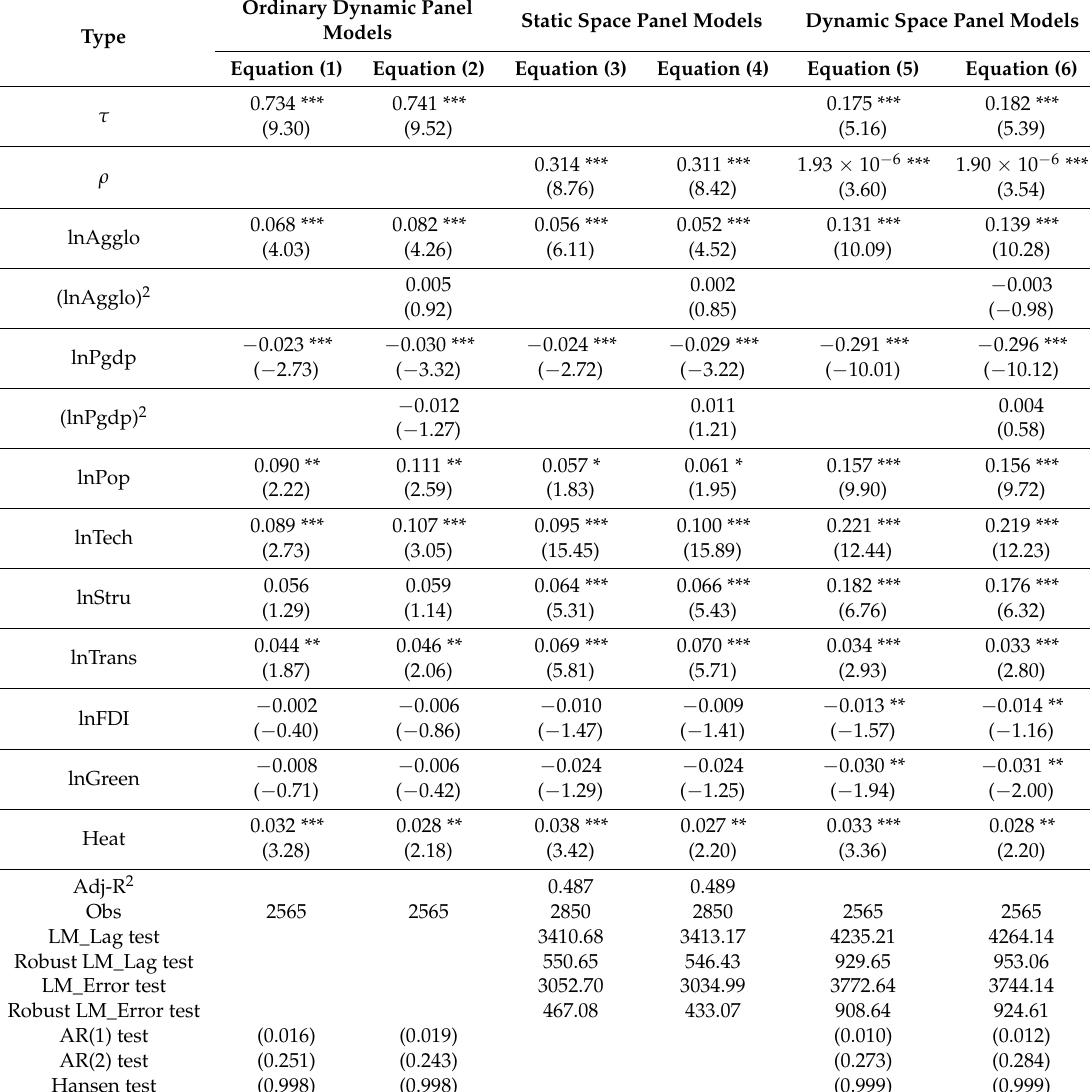
Table 3. Overall Regression